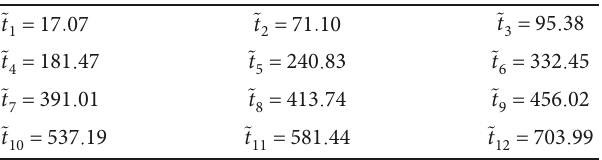
Figure 7: Motion of the body frame of the spacecraft in experiment B with 12 target attitudes. The traces of the x - and y -axes on the unit sphere are represented in grey, whereas the trace of the z -axis is represented in purple. Table 3: Switching times expressed in [s] of the optimal solution of experiment B with 12 target attitudes.